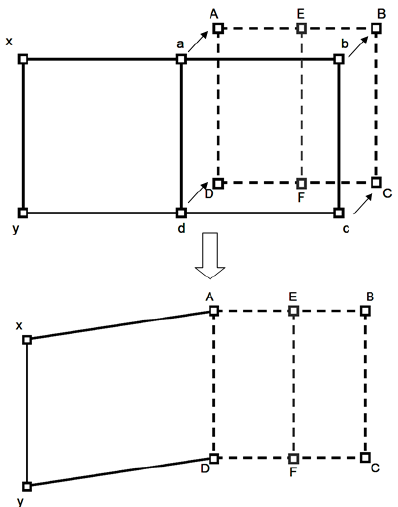
Figure 2. Cadastral boundaries (Solid Lines) and higher accuracy (Dashed Lines). Polygon xady is distorted if point abcd are simply replaced by ABCD (Hope et al.,